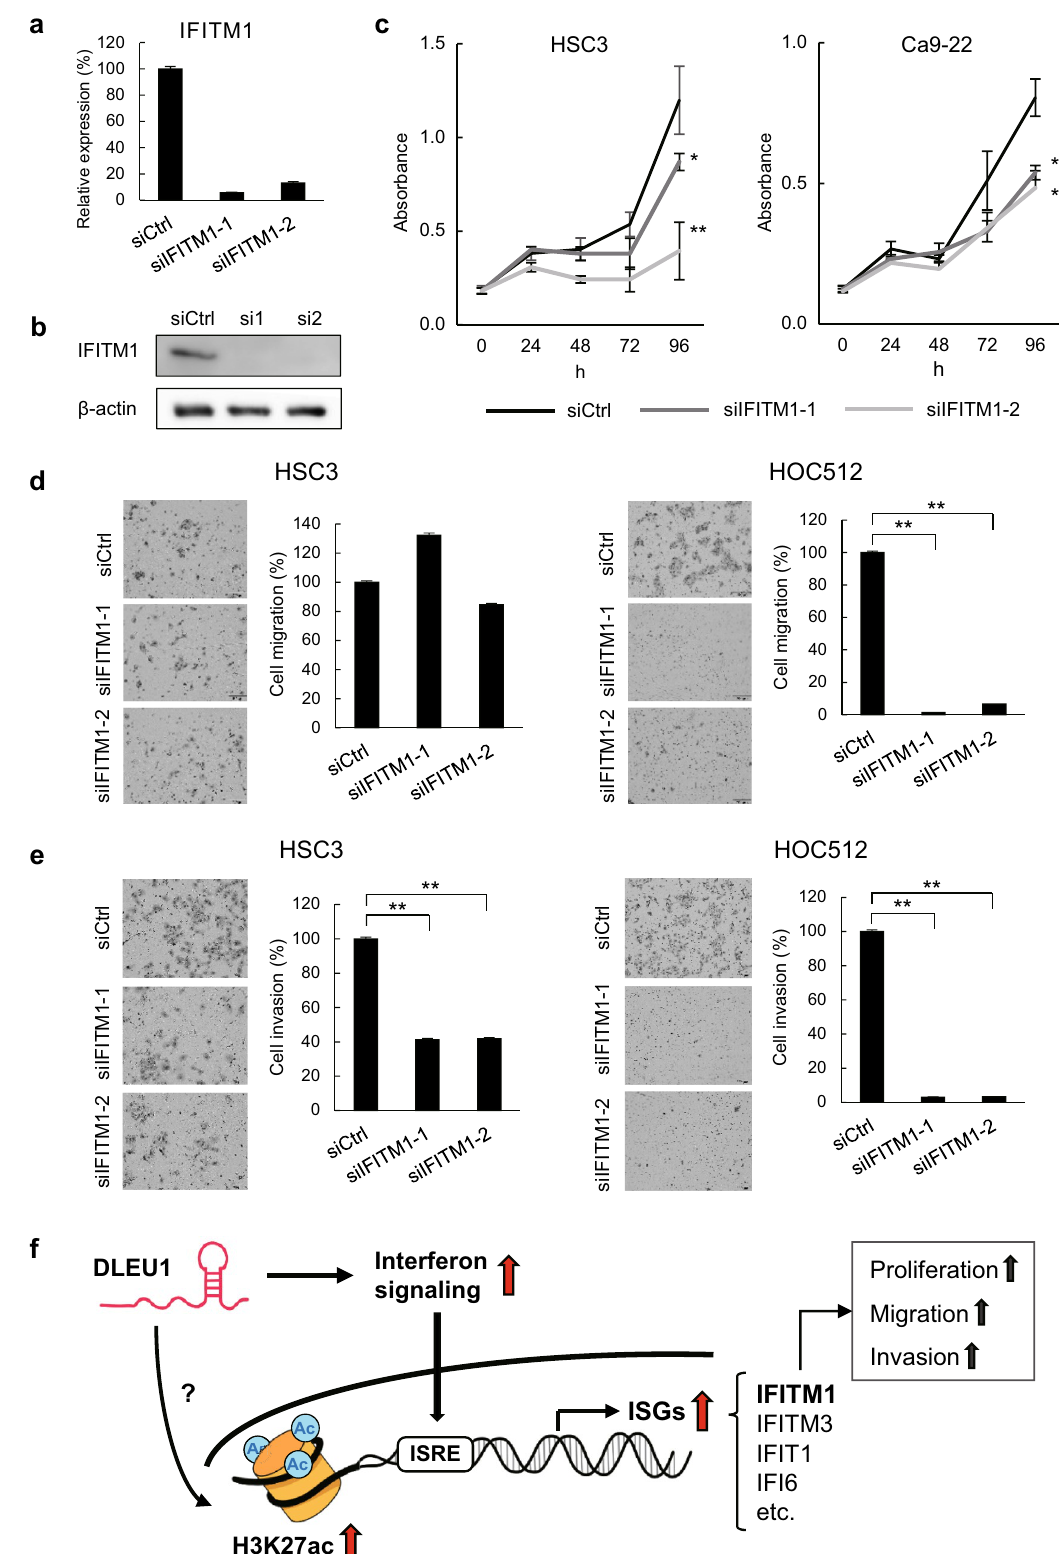
Figure 6. Functional analysis of IFITM1. ( a ) qRT-PCR analysis of IFITM1 in HSC3 cells transfected with the indicated siRNA. ( b ) Western blot analysis of IFITM1 in HSC3 cells transfected with the indicated siRNA. ( c ) Cell viability assays in OSCC cells transfected with the indicated siRNA. ( d , e ) Migration ( d ) and invasion ( e ) by OSCC cells transfected with the indicated siRNA. ( f ) A potential role of DLEU1 in OSCC cells. DLEU1 activates interferon signaling and transcription of ISGs, which may promote tumorigenesis. DLEU1 may also affect histone modification at target genes. * P < 0.05, ** P <